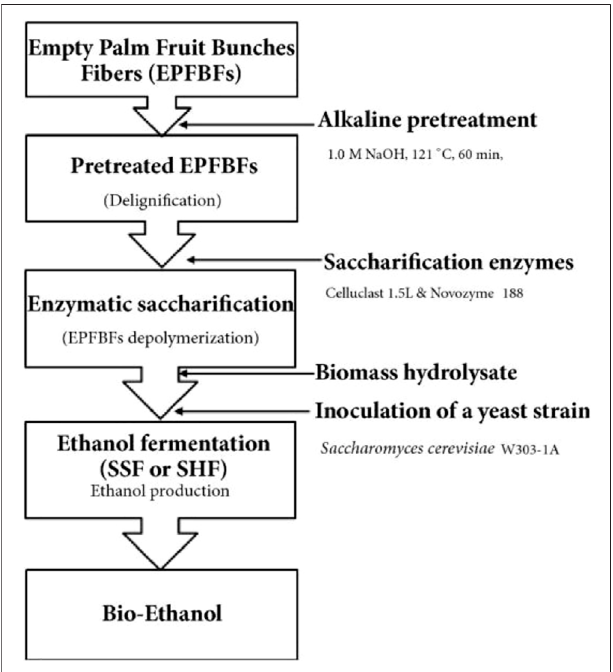
FIGURE 5 | Scheme summary for the production of bioethanol from empty palm fruit bunch fi ber (Kim,